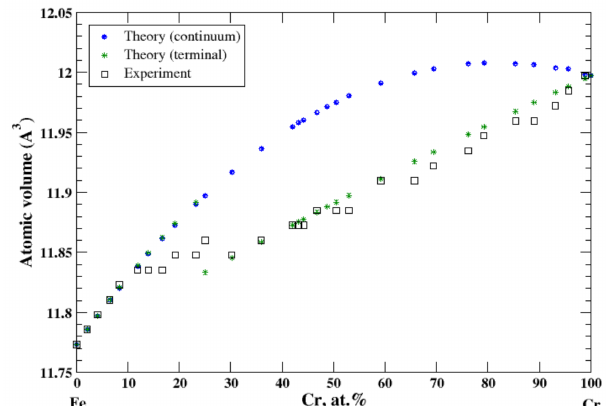
Figure 13. Atomic volume vs. concentration for Fe-Cr alloy system. The experimental data are from Ref. [16] (p. 533 and p.